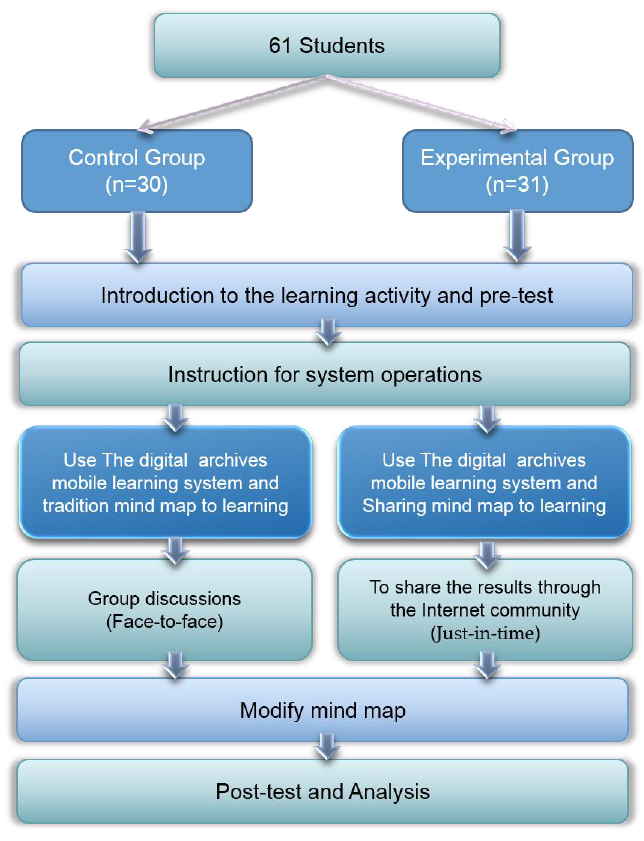
Figure 7. Experimental